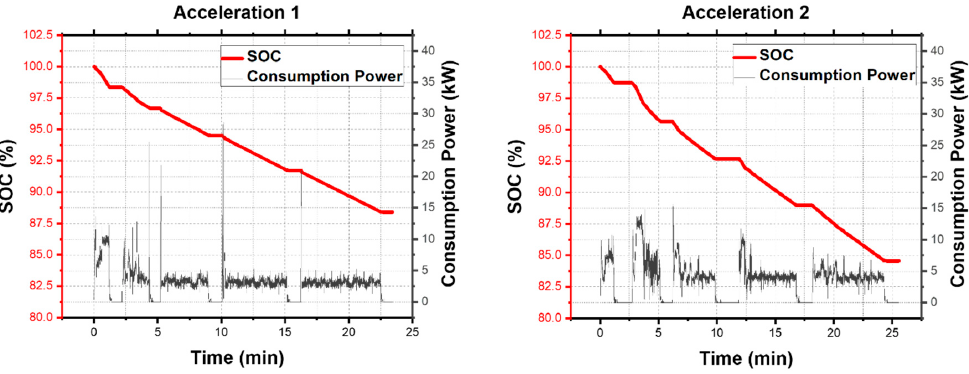
Figure 8. Power consumption trend based on acceleration.